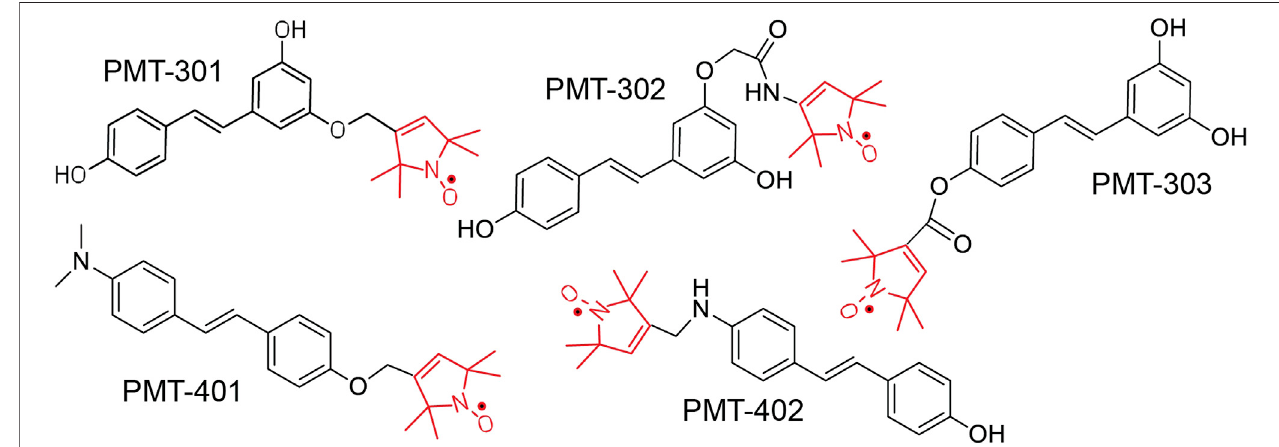
FIGURE1| StructureofParamagneticAmyloidLigand(PAL)candidates.ThestilbenecorebindstooligomericA β ,inhibitingoligomergrowthandtoxicity.Thespin label moiety (red) contains the nitroxide that functions as a catalytic antioxidant.